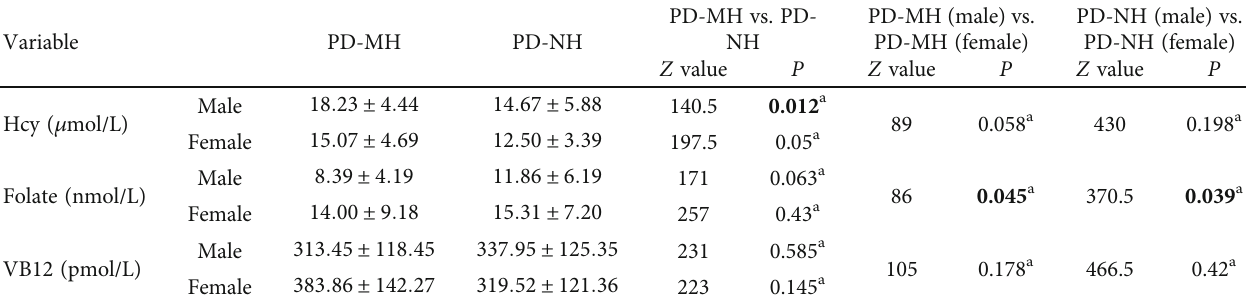
Table 3: Comparison of Hcy, folate, and vitamin B12 levels between MH and NH patients based on